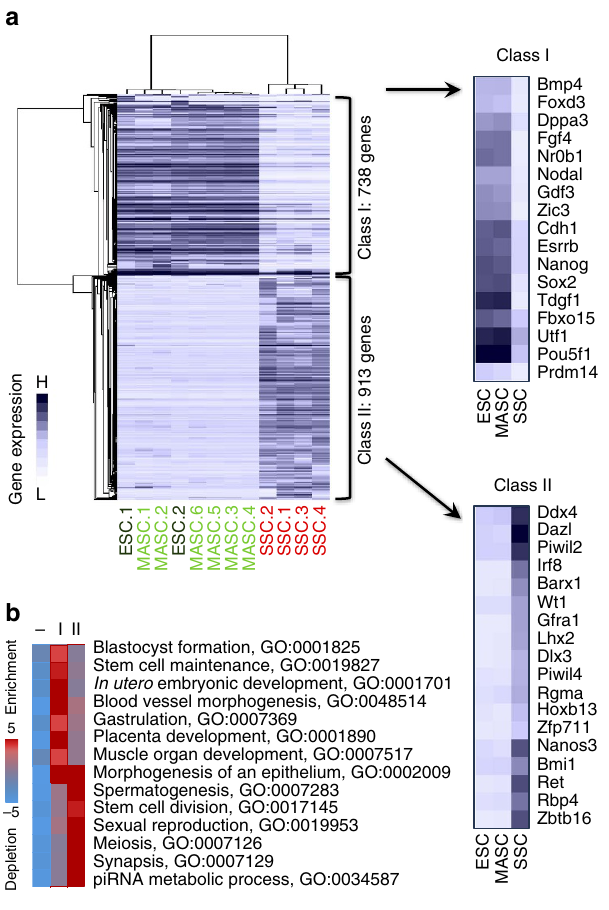
Figure 3 | Activation of early embryonic genes and silencing of spermatogenesis-specific genes in MASCs. ( a ) Differential gene expression profiling among ESCs, MASCs and SSCs. Genes with over two-fold (log2) expression difference between any pair of samples were selected and subjected to hierarchical clustering. Right, average expression profiling in each cell type for example genes in each class. Blue and white indicate relative high and low gene expression, respectively. ( b ) GO enrichment in each gene class. Red and blue indicate relative over- and under-representation,